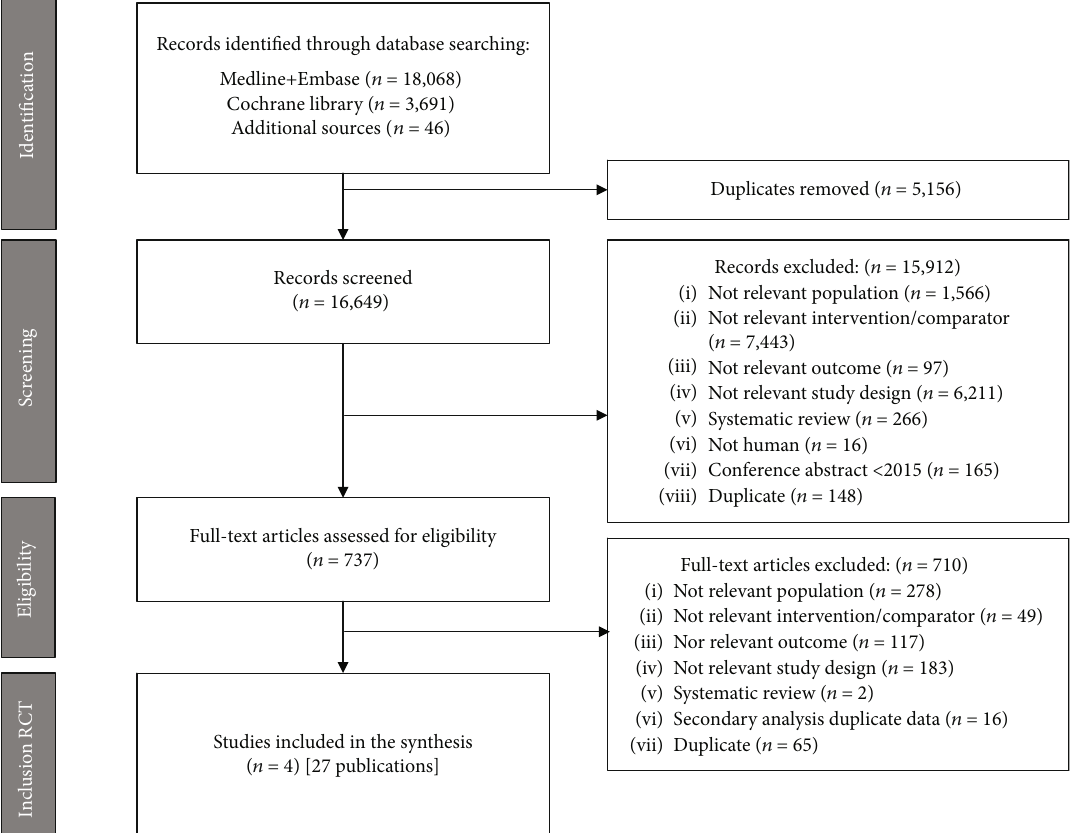
Figure 1: PRISMA fl ow